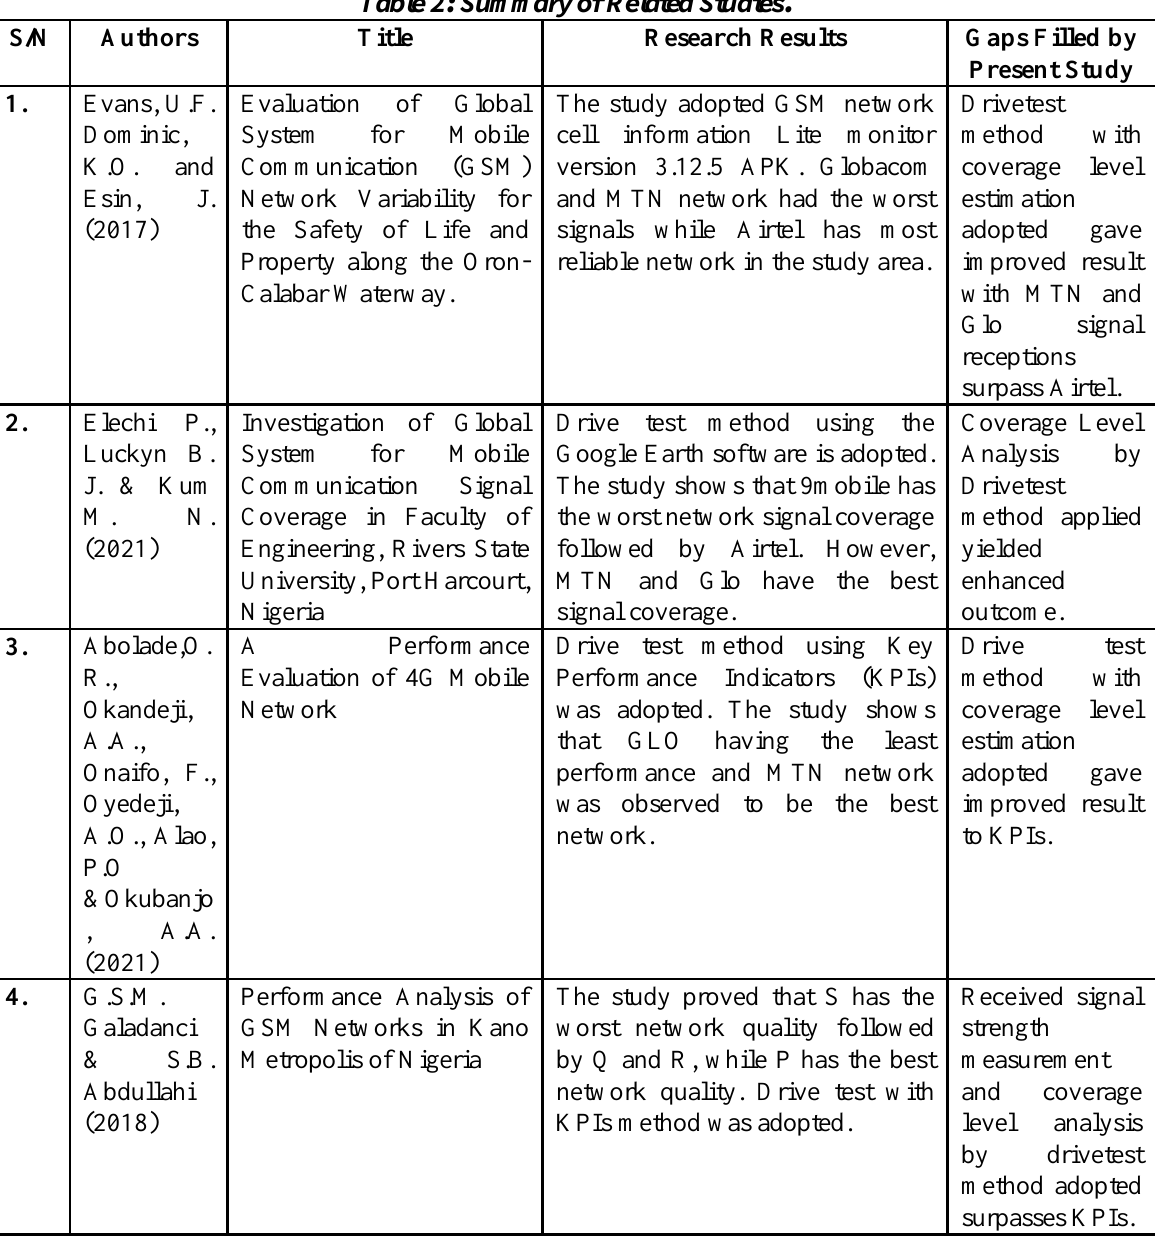
Table 2: Summary of Related